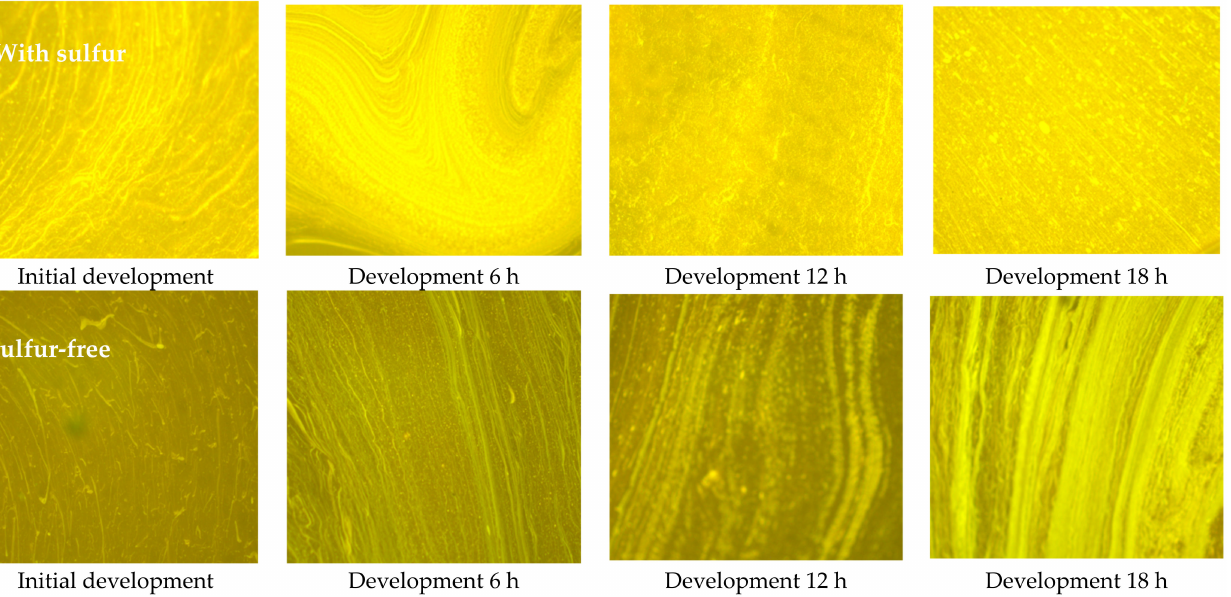
Figure 9. Fluorescence microscopy tests of SBS-modified asphalt with and without sulfur added during high-temperature development (100